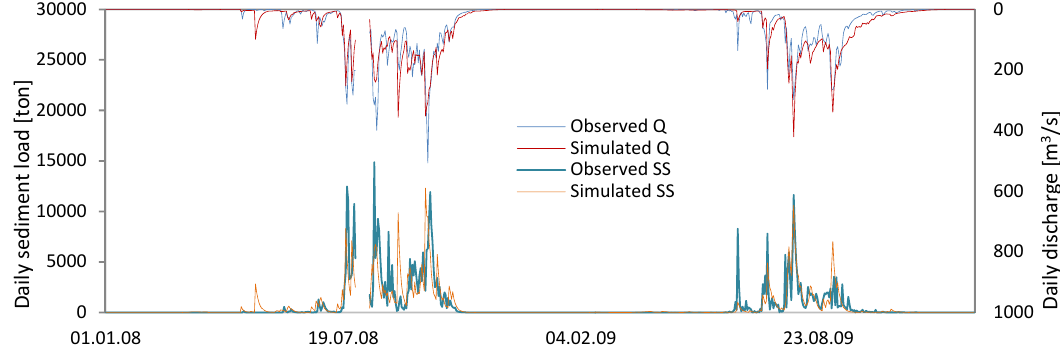
Figure 4. Simulated vs. Observed daily sediment yield for Atchérigbé sub-catchment (6978 km 2 ). Calibration period was 2008 (R 2 = 0.66 and ME = 0.64), validation period was 2009 (R 2 = 0.67 and ME = 0.67). SSC = suspended